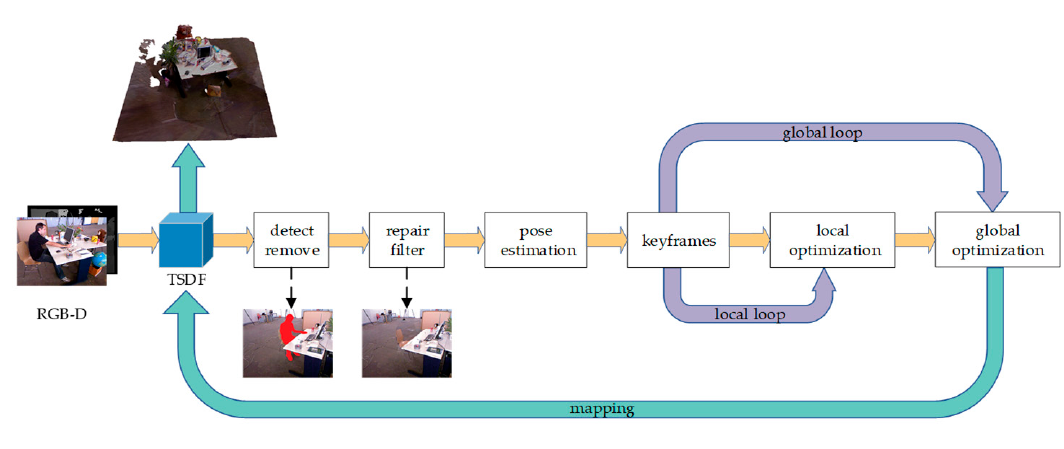
Figure 1. Overview of the proposed RGB-D SLAM system based on BundleFusion.